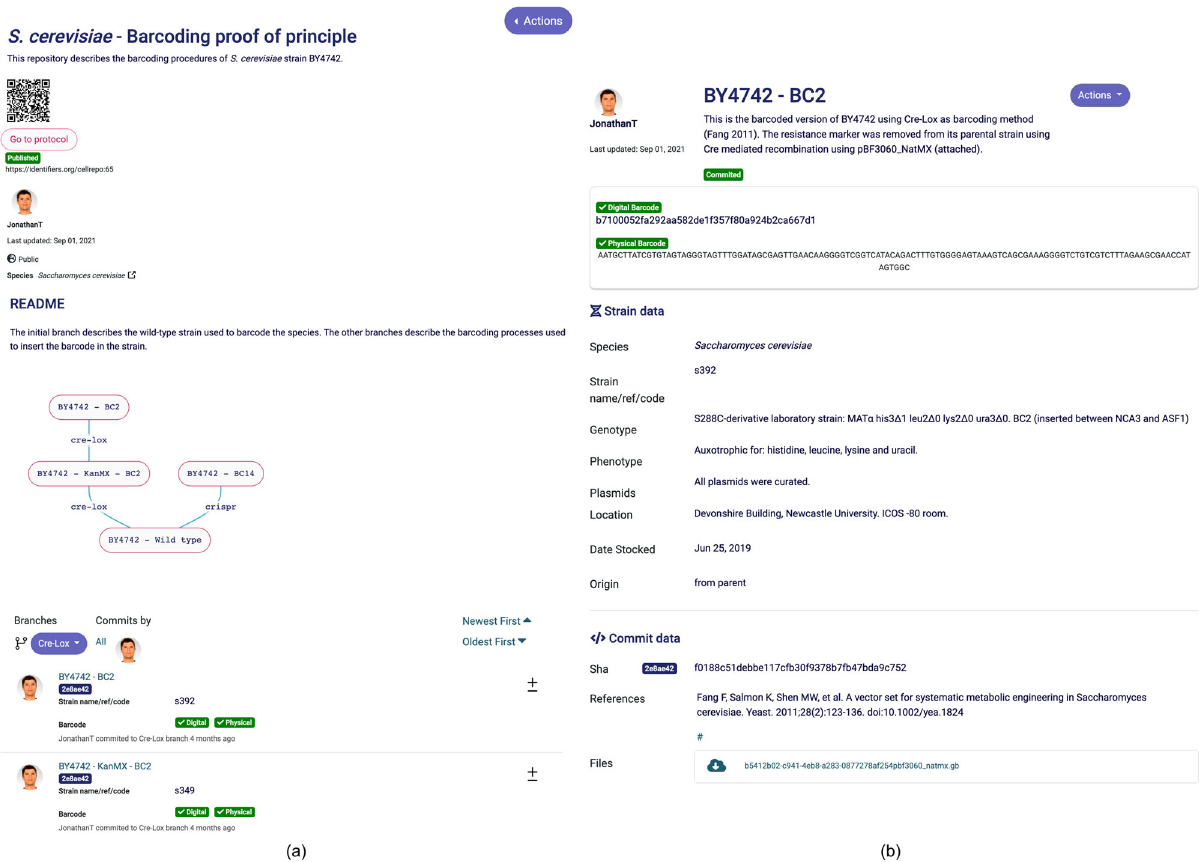
Fig. 3 Cell repository details. a Strain Engineering Repositories contain all the digital footprint produced during the engineering of a cell line. The repository provides general information about the cell line project (in this example, the barcoding proof of principle of S. cerevisiae ). It also contains all the different “ commits ” that were made during the engineering process. b A commit represents a related set of changes introduced into a cell line. All commits have a unique digital identi fi er and some commits (decided by the user) may also have a physical identi fi er barcode that is physically inserted into the cell chromosome. Recovering the barcode by sequencing allows a cell engineer to recover the id of the commit containing all the digital footprint of the cell